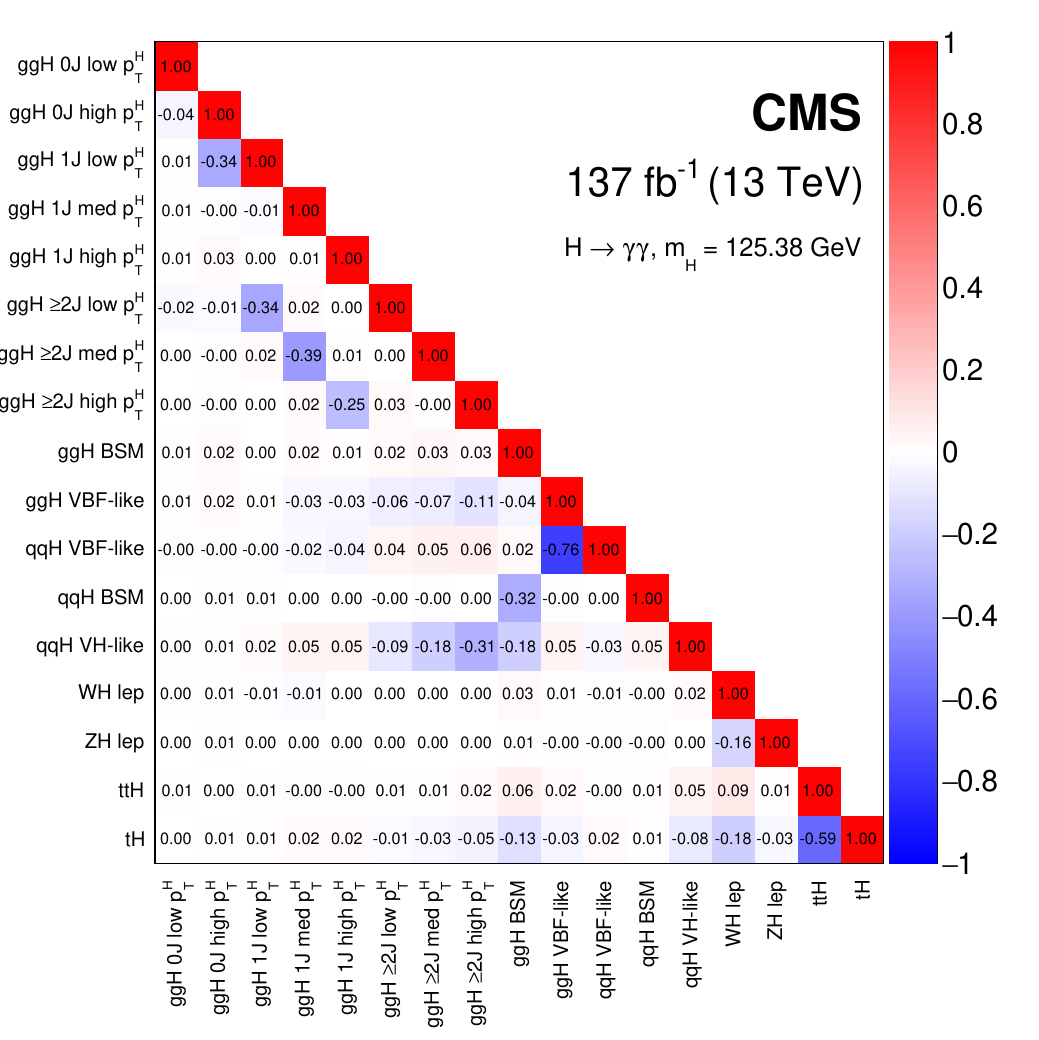
Figure 19 . Observed correlations between the 17 parameters considered in the maximal merging STXS fit. The size of the correlations is indicated by the colour